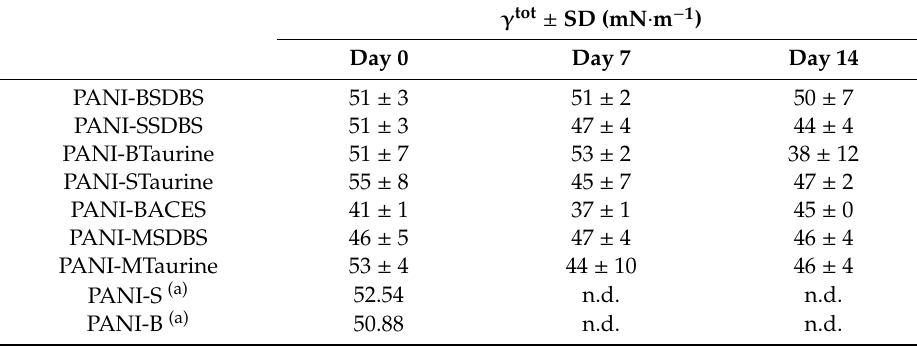
Table 1. The surface energy of modified PANI surfaces, γ tot , determined immediately after preparation, and after 7 and 14 days on the stored under laboratory conditions. The values are compared with γ tot of neat PANI-S and PANI-B films.